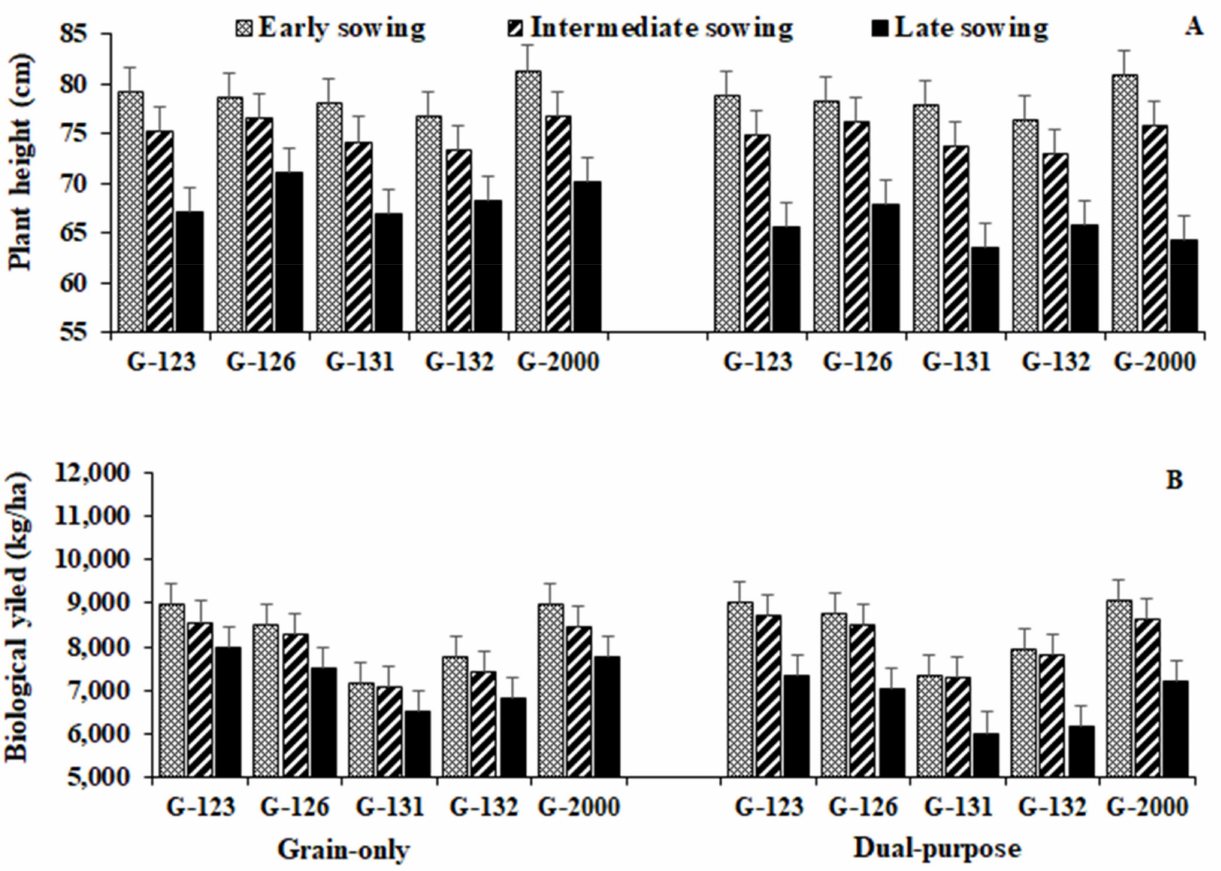
Figure 3. Influence of sowing date and forage cutting on plant height ( A ) and biological yield ( B ) in five barley genotypes under salinity conditions averaged over the two growing